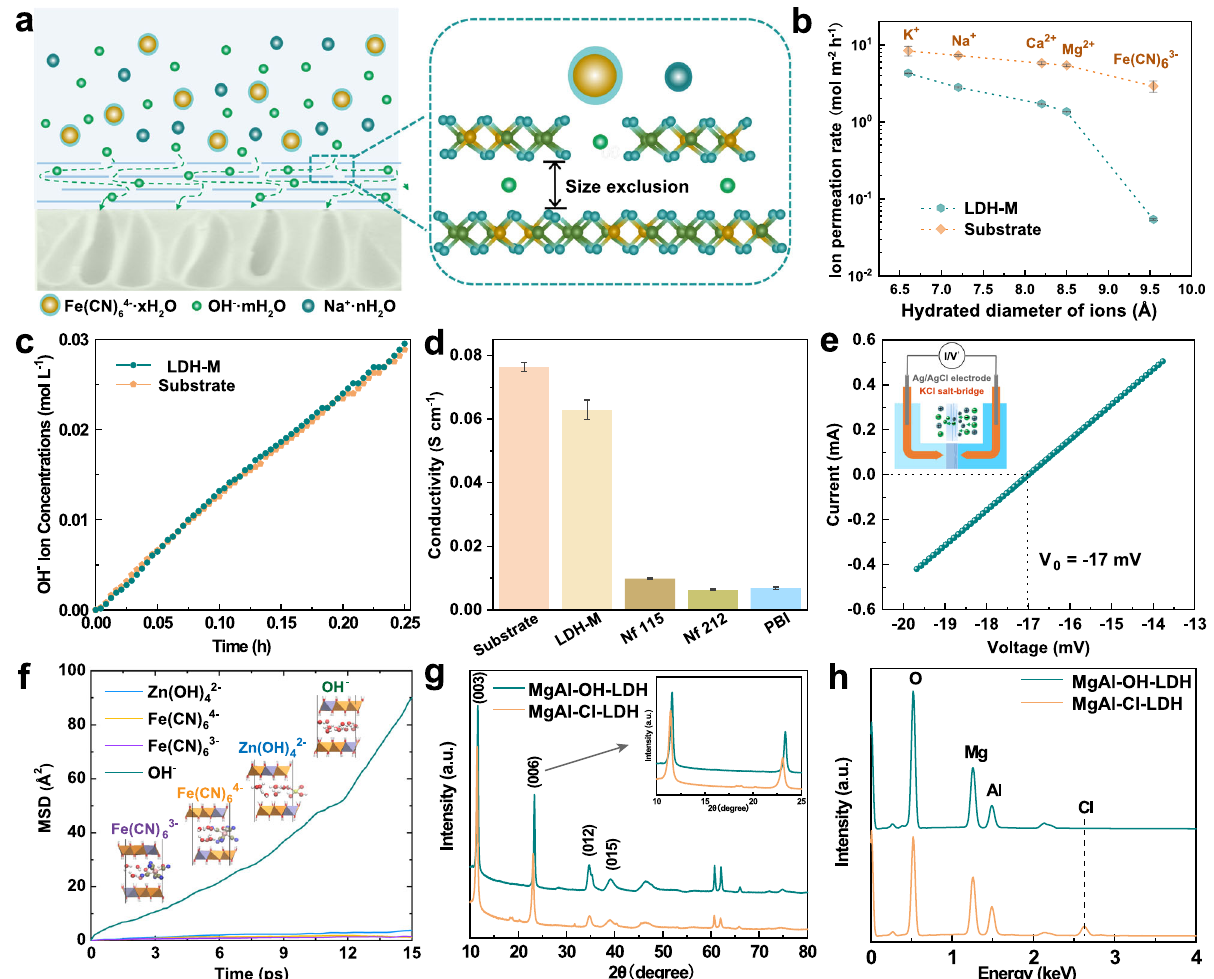
Fig. 3 Ionic selectivity and conductivity of LDH-M. a Schematic illustration of the structure of LDH-M and selective ions screening. b Selective ions permeation of common salts through LDH-M and substrate. Error bars are standard deviations using at least three measurements from different samples. c The permeability of hydroxide ions through LDH-M and substrate. d Ionic conductivity of different membranes at 298 K. Error bars are standard deviations using at least three measurements from different samples. e The current – voltage (I – V) pro fi le of LDH-M measured in a NaOH concentration gradient of 1 – 3 mol L − 1 (The solutions on the left and the right sides of the cells are 1 mol L − 1 and 3 mol L − 1 NaOH solutions, respectively). Inset: schematic illustration of I – V testing device. f MSD of hydroxide, zincate, ferrocyanide, ferricyanide ions in LDHs at 298 K. g XRD patterns of the prepared LDHs (MgAl-Cl-LDH) and NaOH-treated LDHs (MgAl-OH-LDH). Notably, the right shift of the characteristic peak represents the intercalation of hydroxide ions between layers for LDHs treated with NaOH. h EDS spectra of MgAl-Cl-LDH and MgAl-OH-LDH, the disappearance of Cl peak demonstrates that Cl − has been successfully exchanged by OH −